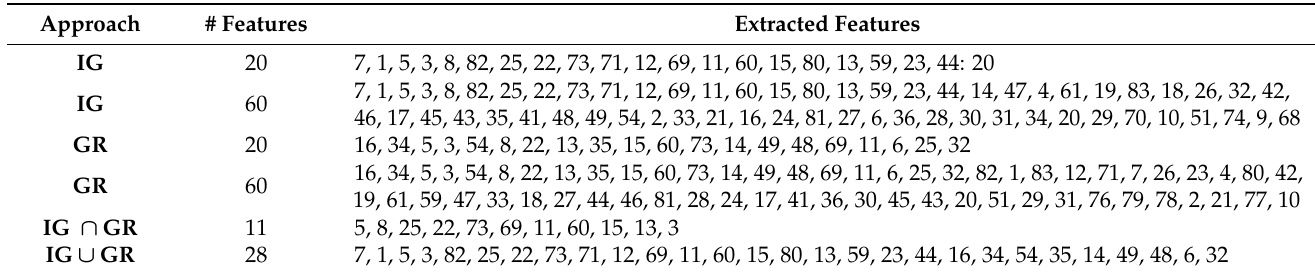
Table 2. Results from the ranking features process applied to the IoTID20